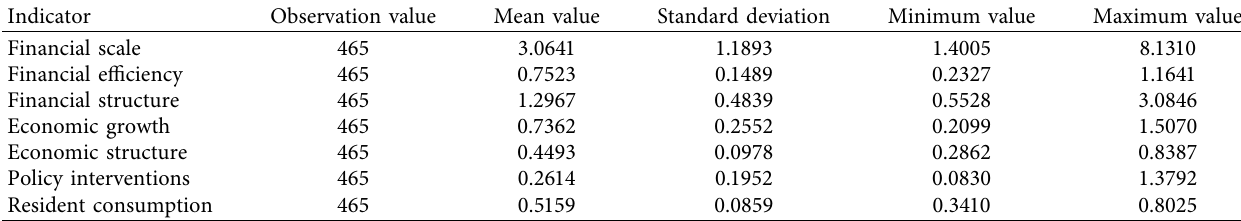
Table 2: Descriptive statistics of indicator